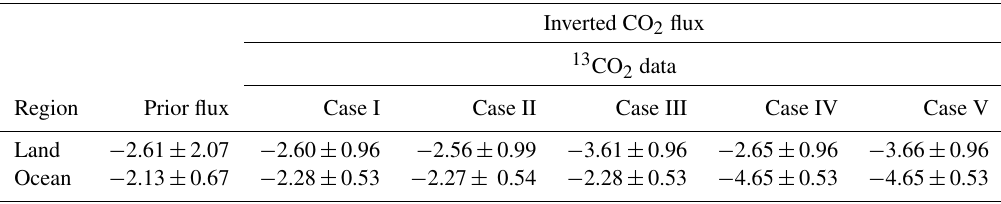
Table 6. Inverted fluxes (Pg Cyear − 1 ) , averaged for 2002–2004, for land and ocean regions using 13 C data only. The negative sign denotes the flux from the atmosphere to the surface (sink). Various treatments are made to 13 C discrimination and disequilibrium fluxes represented by the cases outlined in Table